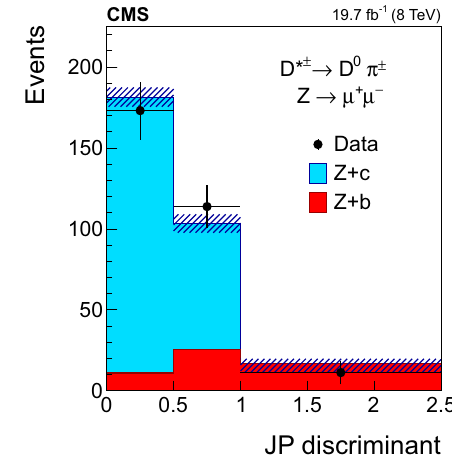
Fig. 9 Background-subtracted distributions of the JP discriminant in the dielectron (left) and dimuon (right) channels for Z + jets events with a D ∗ ( 2010 ) ± → D 0 π ± → K ∓ π ± π ± candidate. The shape of the Z + c and Z + b contributions is estimated as explained in the text. Their normalization is adjusted to the result of the signal extraction fit.